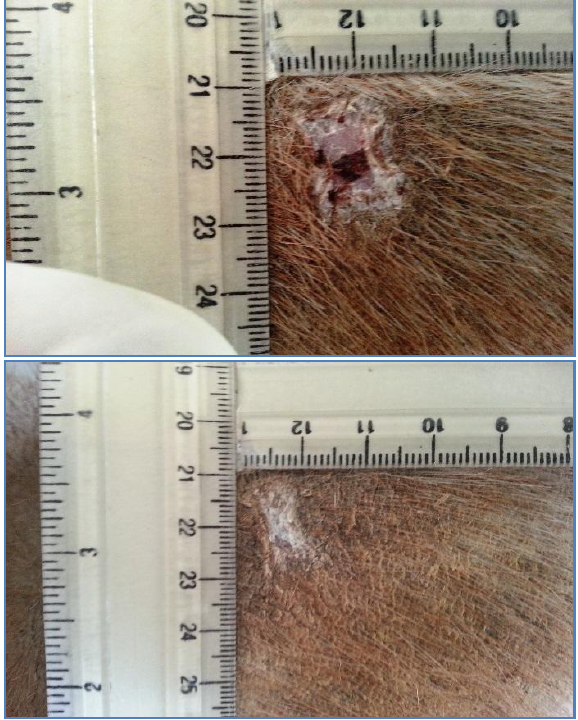
Figure, 2: The significant differences in rate of wound closure between control (C) and treatment (T) wounds, 35 days post-wounding.